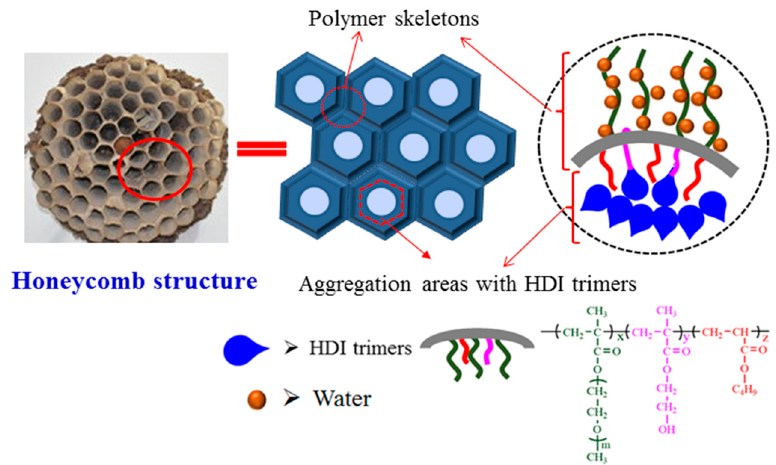
Figure 3. Schematic diagram of the honeycomb structure.